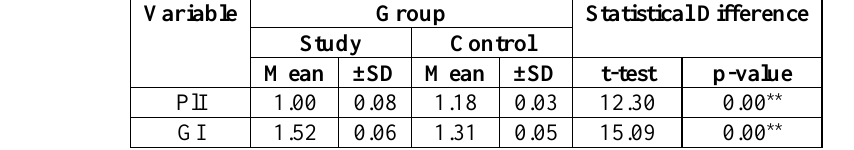
Table1: Plaque index and gingival index(mean±SD) among the study andcontrol groups.